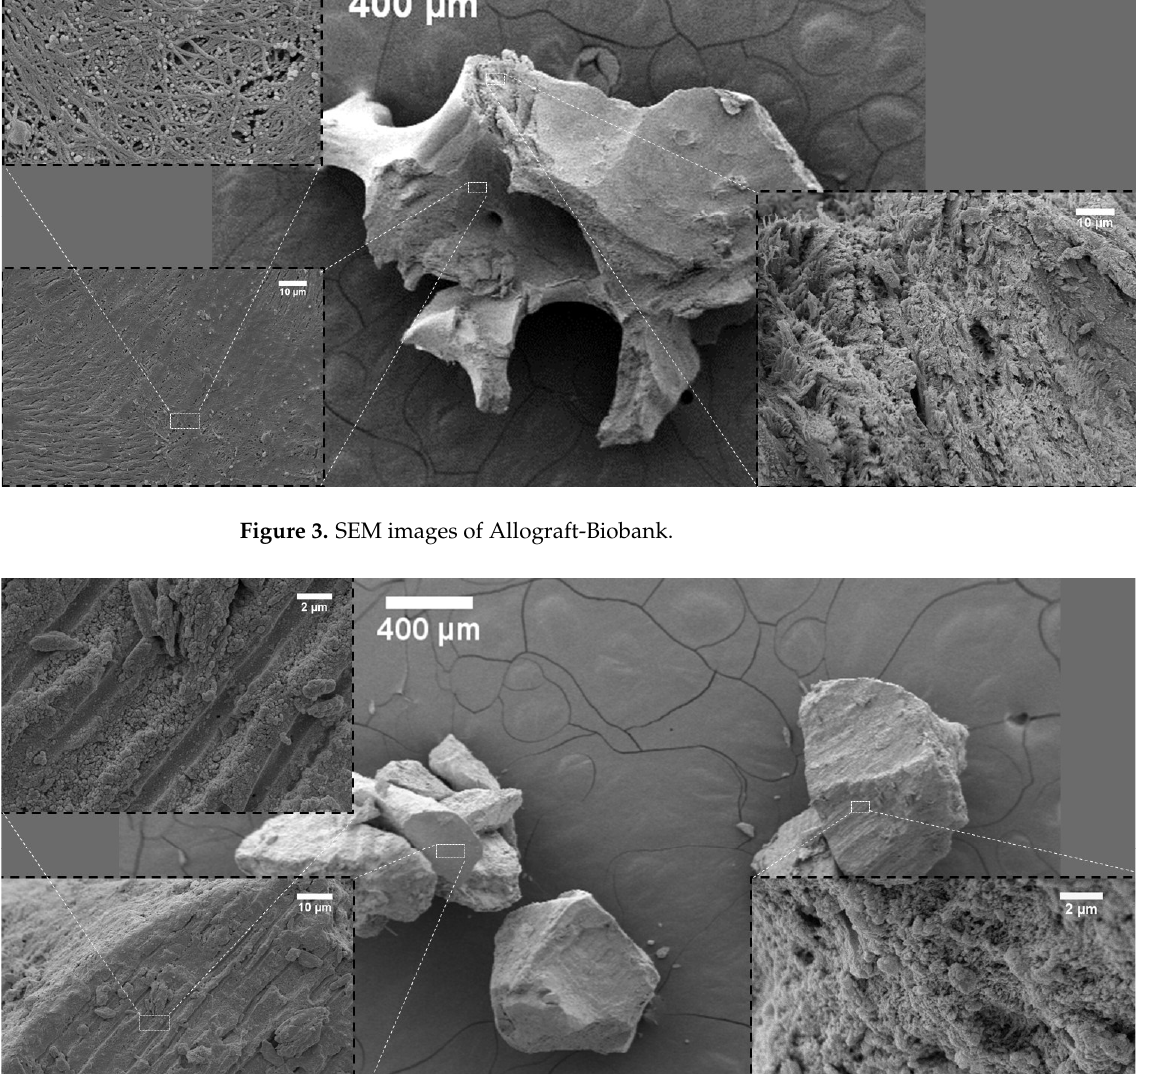
Figure 5. SEM images of Geistlich Bio-Oss. 2.2. Elements Content The EDS analysis was performed to study the materials’ chemical composition. The individual elements content is listed in Table 1, and it is also graphically presented in Figure 6. The EDS analysis provides the information that, as expected, the bone grafting materials were composed mainly of calcium, phosphate, and oxygen atoms. It should be pointed out that the allograft materials (Allograft-Katowice, Allograft-Zimmer, and